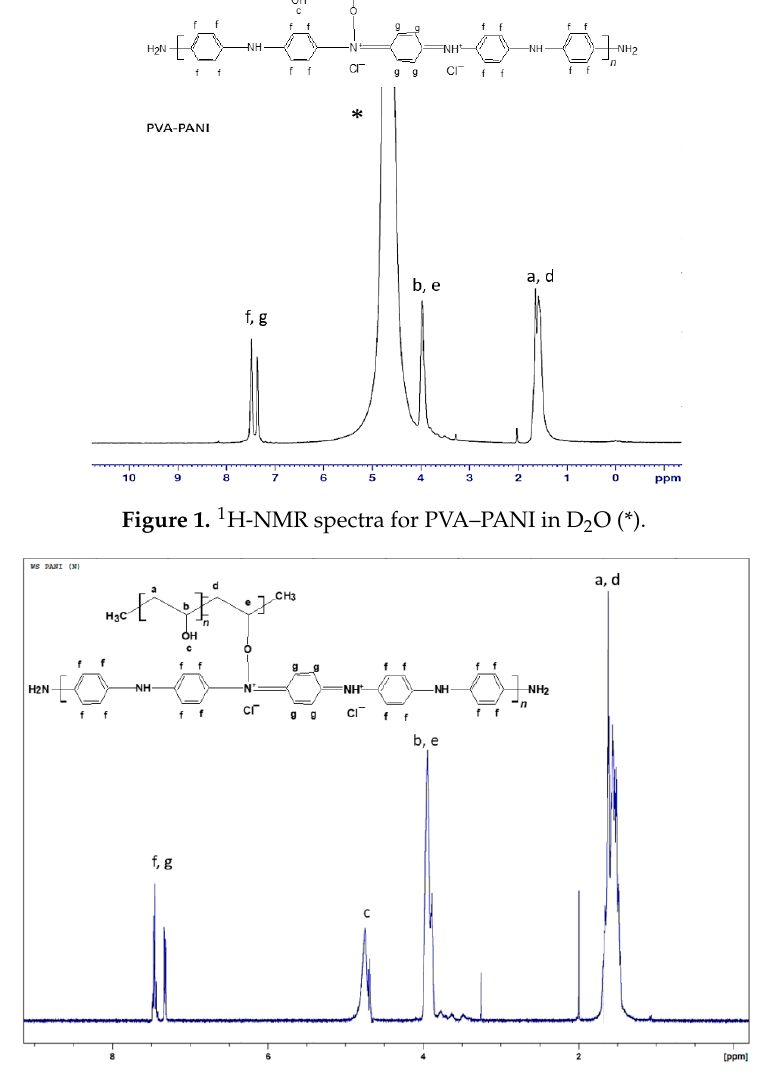
Figure 1. 1 H-NMR spectra for PVA–PANI in D 2 O (*).